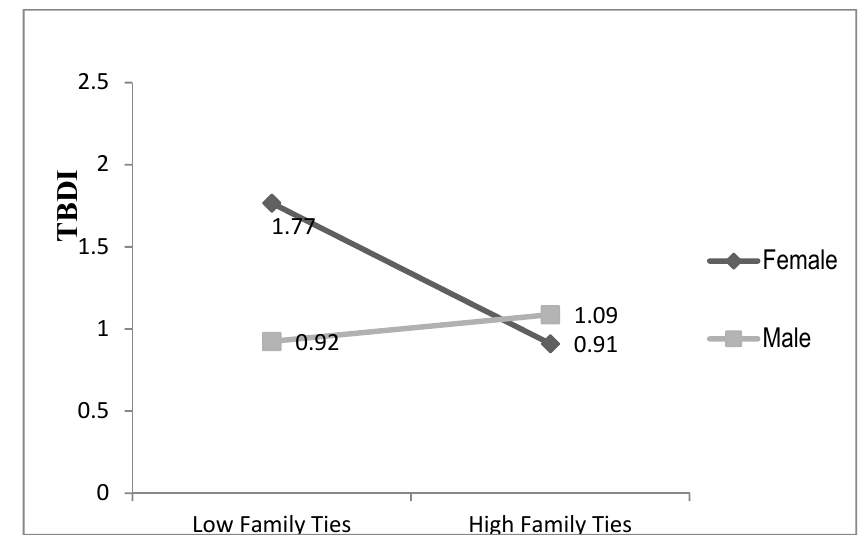
Figure 3. Family Ties by Gender Explaining Distress.